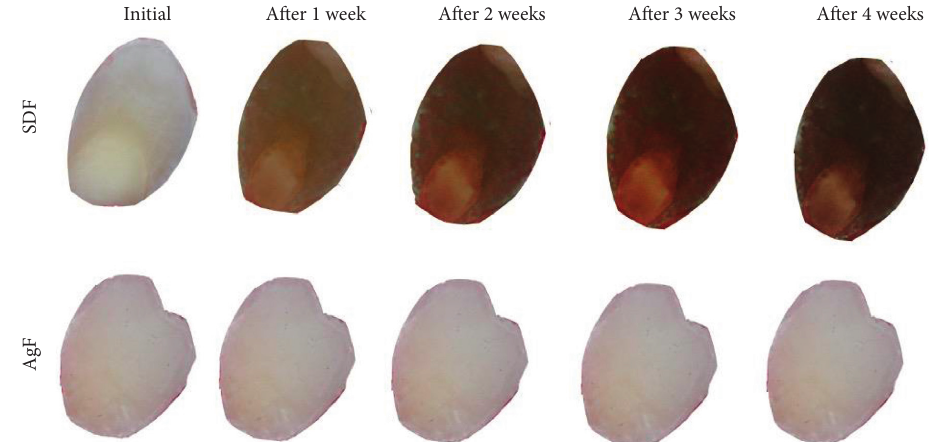
Figure 6: Photographic image of superficial enamel demineralized specimens treated with SDF and AgF, 4-week follow-up.